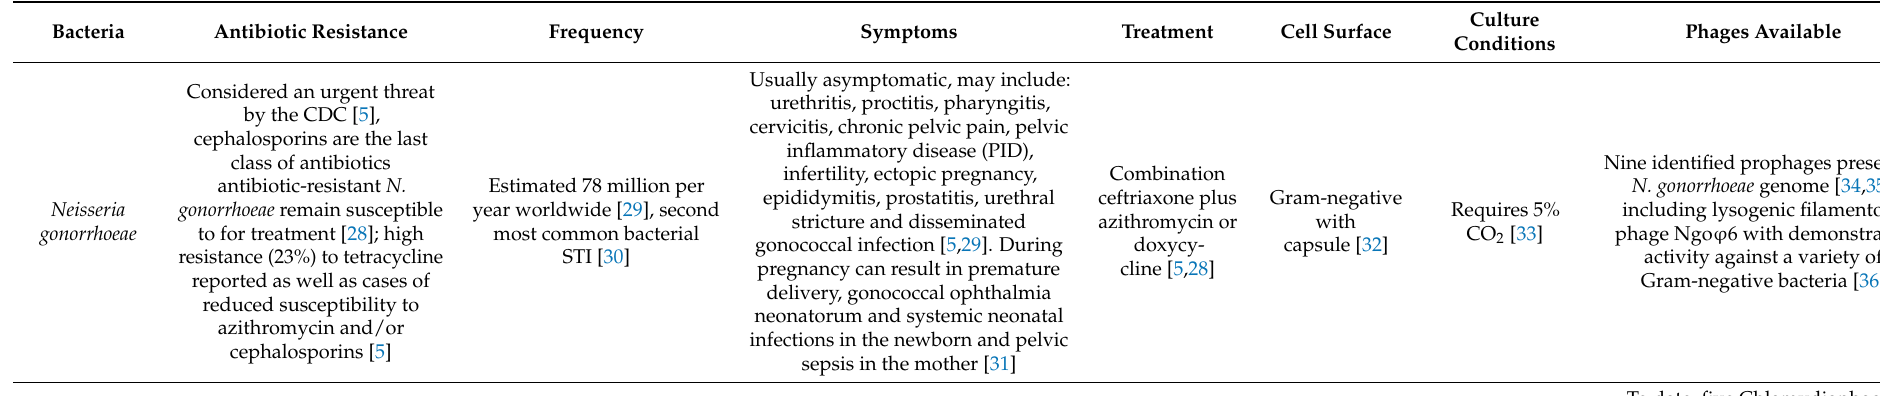
Table 1. Relevant information for consideration of usefulness of phage therapy. Included is information on antibiotic resistance, relative frequency, symptoms and current treatment methods of the bacterial STIs mentioned. In addition, the phenotypic characteristics of the bacterial cell including the cell wall presence and capsule presence, as well as the bacteria’s ideal or required growth conditions. Finally, the phages available for each bacterial STI as well as relevant phage research are